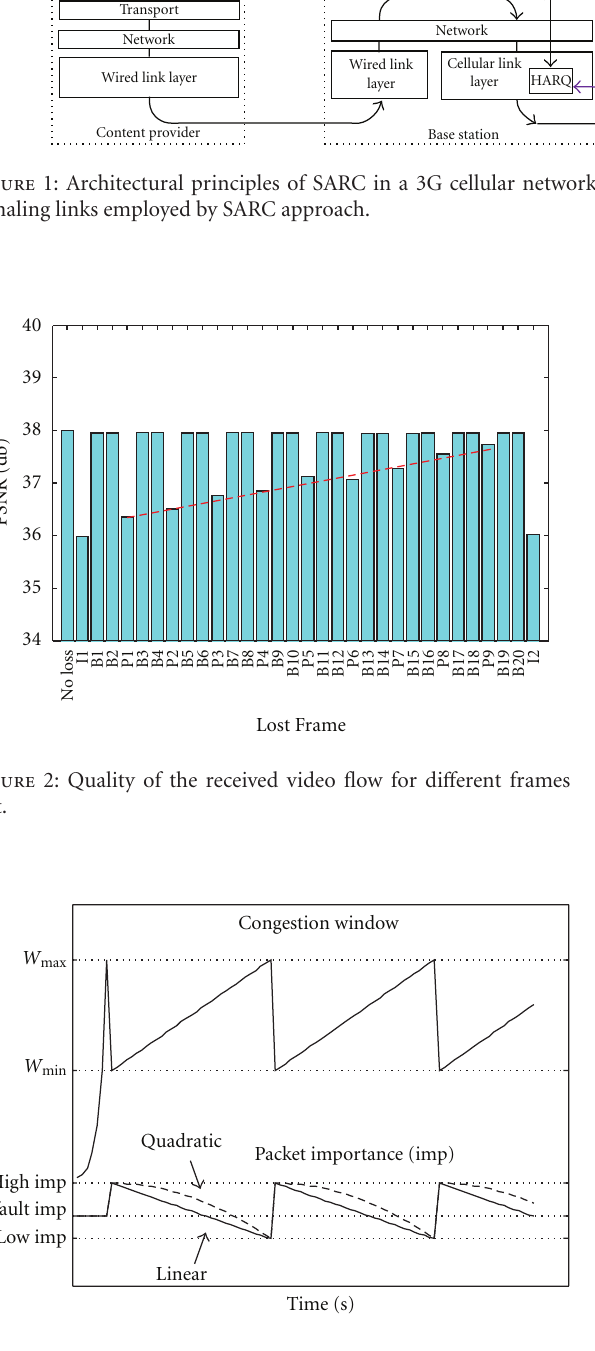
Figure 3: Variation of HARQ strength used for TCP packet transmission based on the congestion window parameter estimated at the